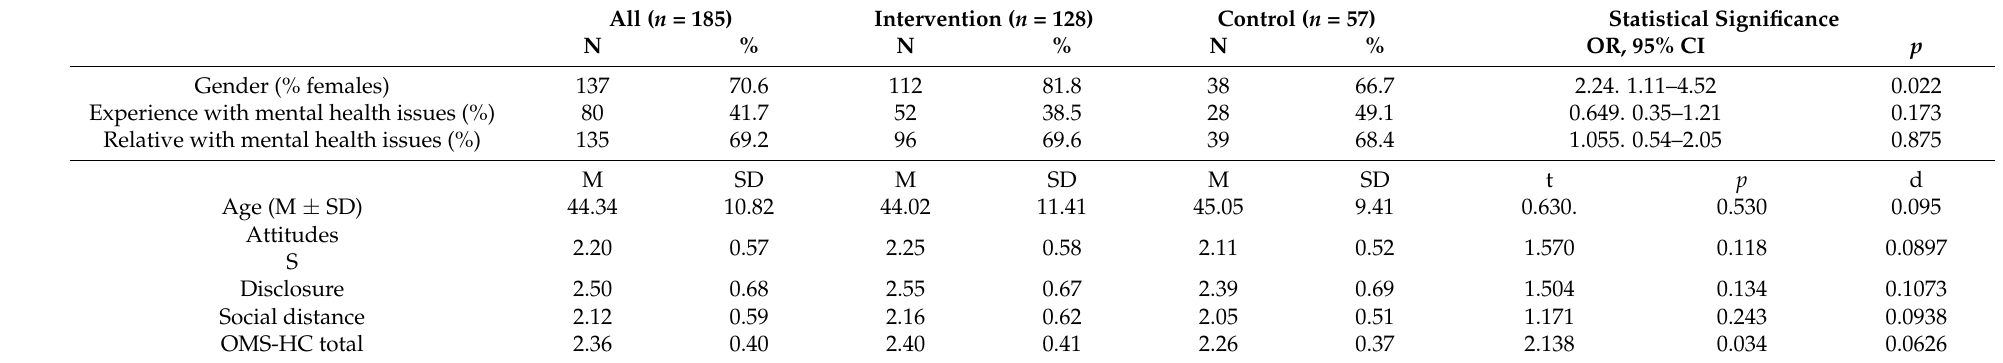
Table 1. Sociodemographic characteristics and baseline scores of primary care participants.